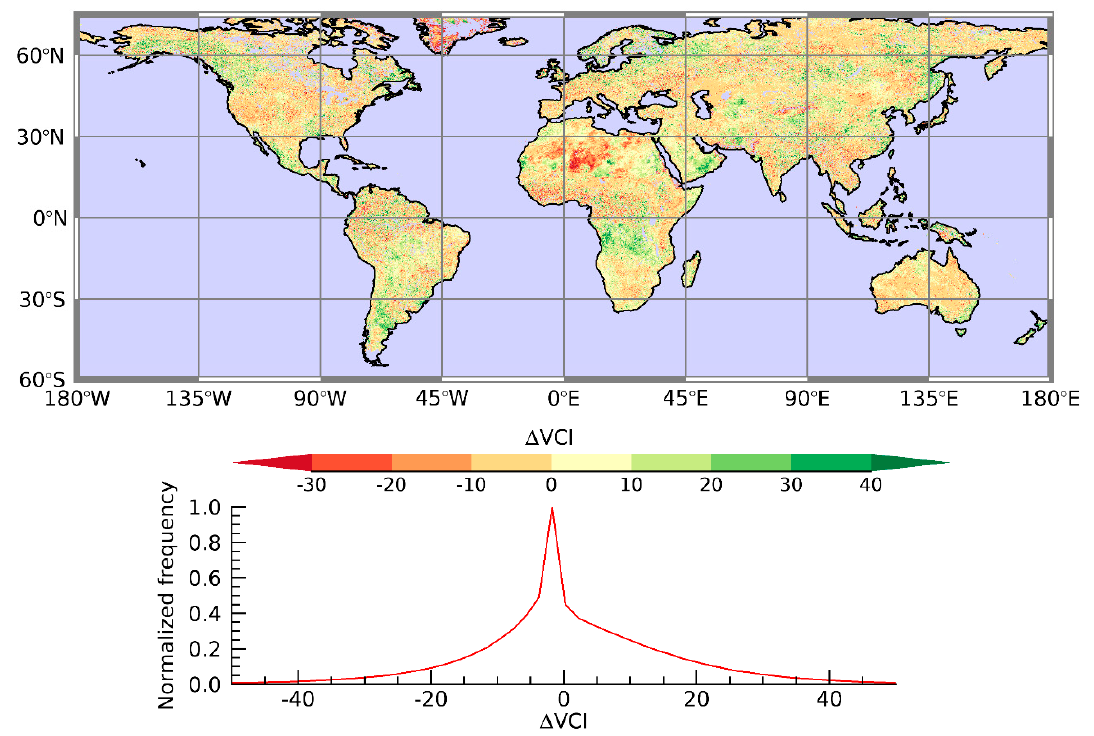
Figure 2. Pixel-level (4 km resolution) difference between Visible Infrared Imaging Radiometer Suite (VIIRS) Vegetation Condition Index (VCI) and Advanced Very High Resolution Radiometer (AVHRR) VCI derived during the period Week 30 (23 – 29 July), 2016 and its histogram.